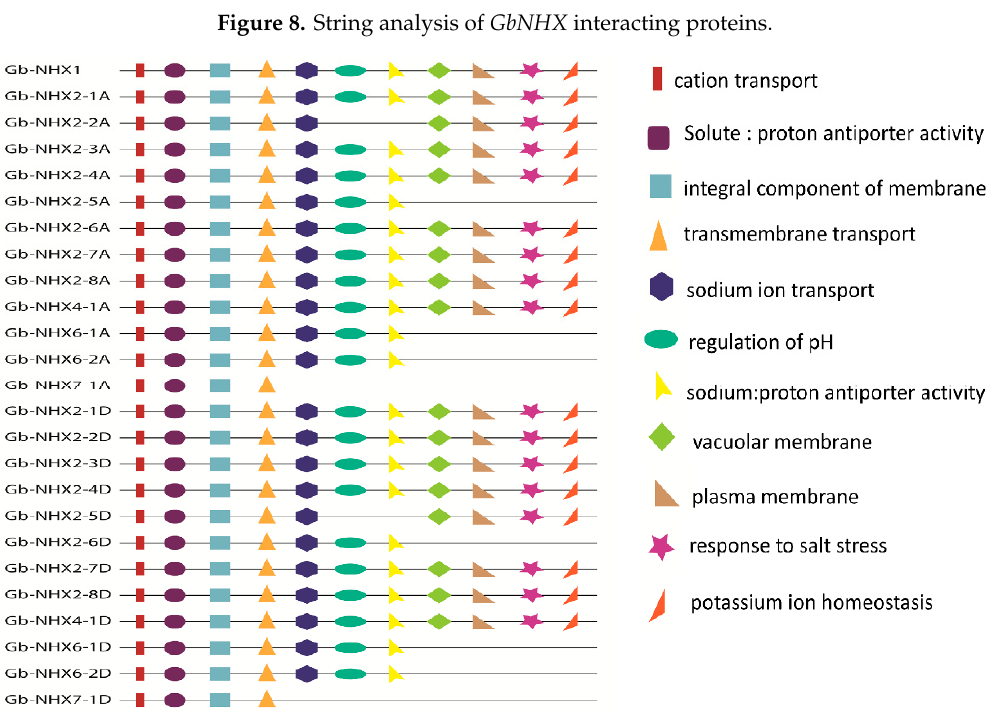
Figure 9. Gene ontology (GO) terms of GbNHX genes. Different GO terms are represented by different shapes.